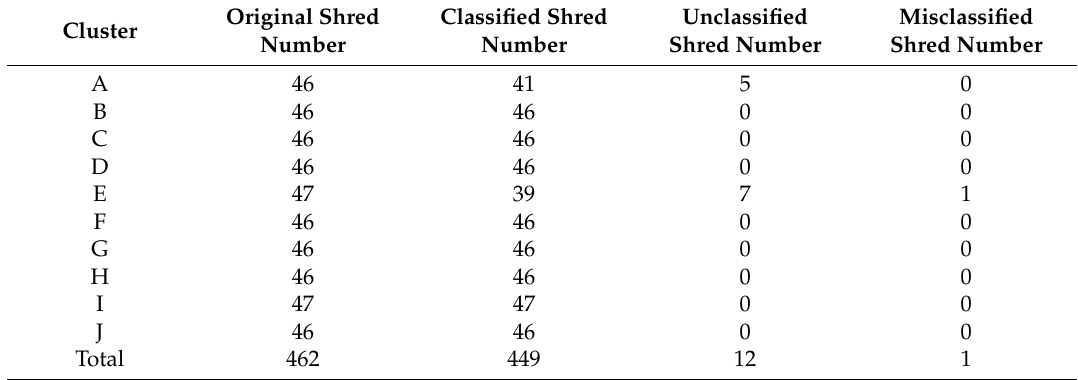
Table 2. Final clustering results.